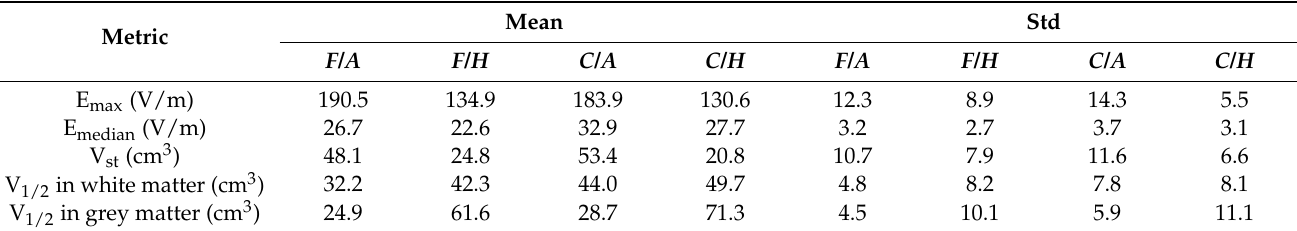
Table 1. Statistics of stimulation metrics per investigated scenario. (F/A: frontal coil position on anatomical models, F/H: frontal coil position on homogeneous models, C/A: central coil position on anatomical models, C/H: central coil position on homogeneous